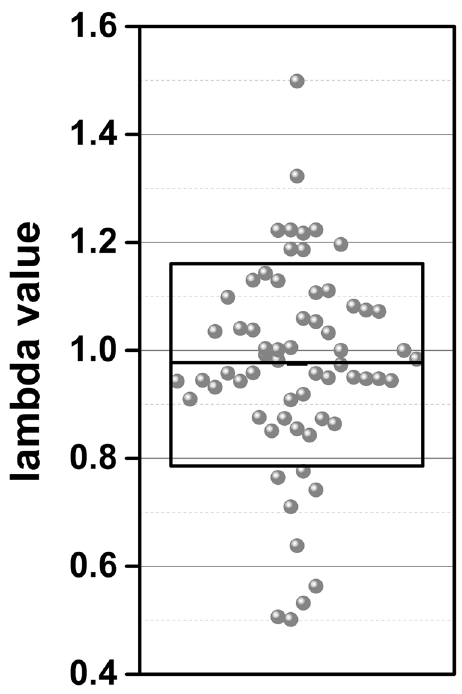
Figure 4. Values of the correction factor lambda ( λ ) identified for each applied SNAP. Lambda values presented as box-plot showing raw data (spheres), standard deviation (whiskers), 25 and 75 percentile (box) and the median (horizontal